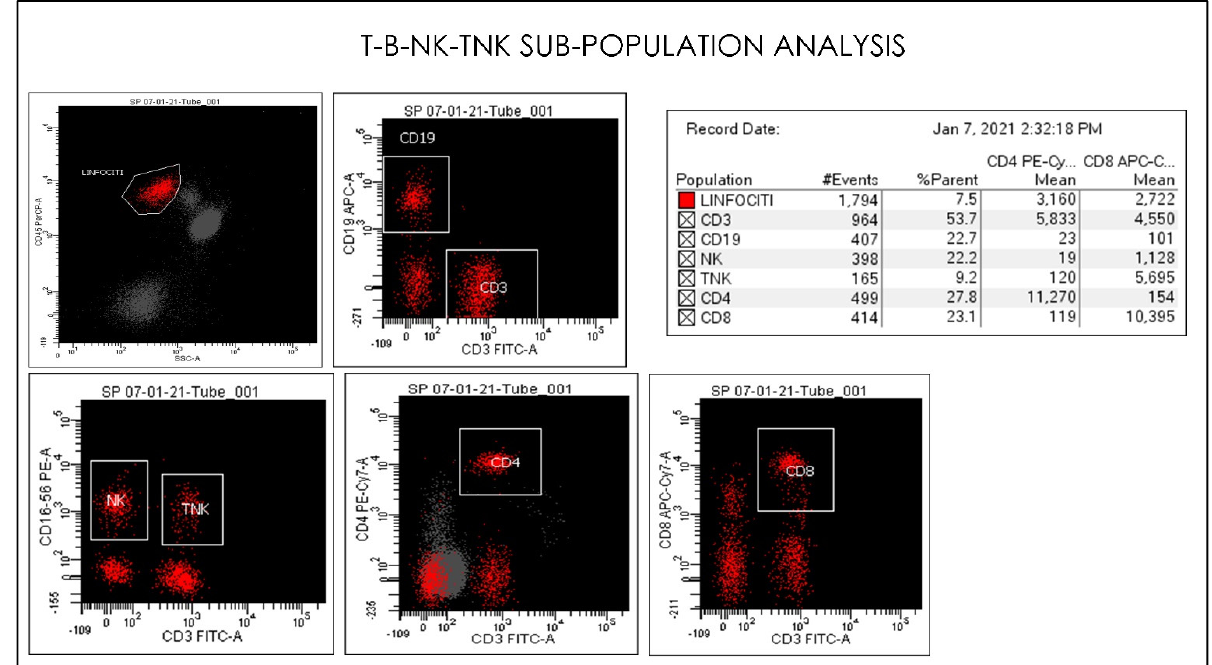
Figure 10. Gating Strategy for lymphocytes CD4, CD8, CD3, CD19, NK, and TNK. quantification. Comparative Dot plots of CD3 on X-axis vs. CD4, CD8, CD3, CD19, NK, and TNK. A doublet exclusion gate based upon (FSC-A vs. FSC-H) was utilized to gate on singlet cells, and within this singlet cell gate a lymphocyte gate was drawn in a dot plot of FSC-A vs. SSC-A. The instruments were set using one set of target values as described in the Method section of this paper. Percentages of positive cells were determined after gating on CD45 positive cells following the doublet